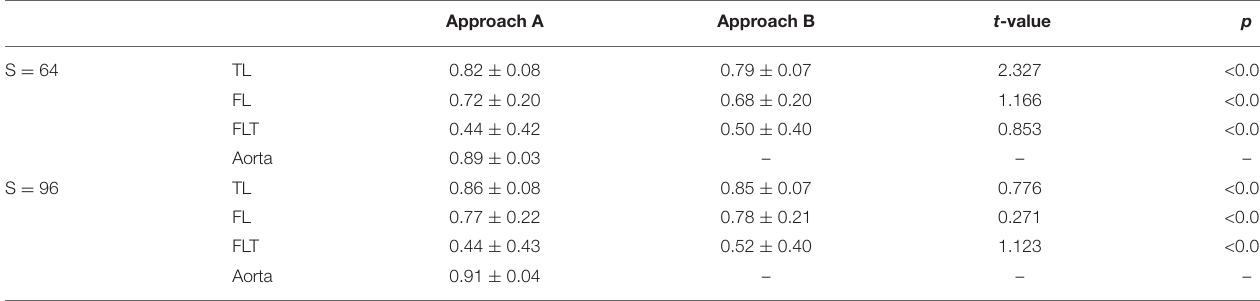
TABLE 2 | Mean and standard deviation of Dice score of baseline method, and t -test value between the Approach A and Approach B for four substructures segmentation in TBAD.